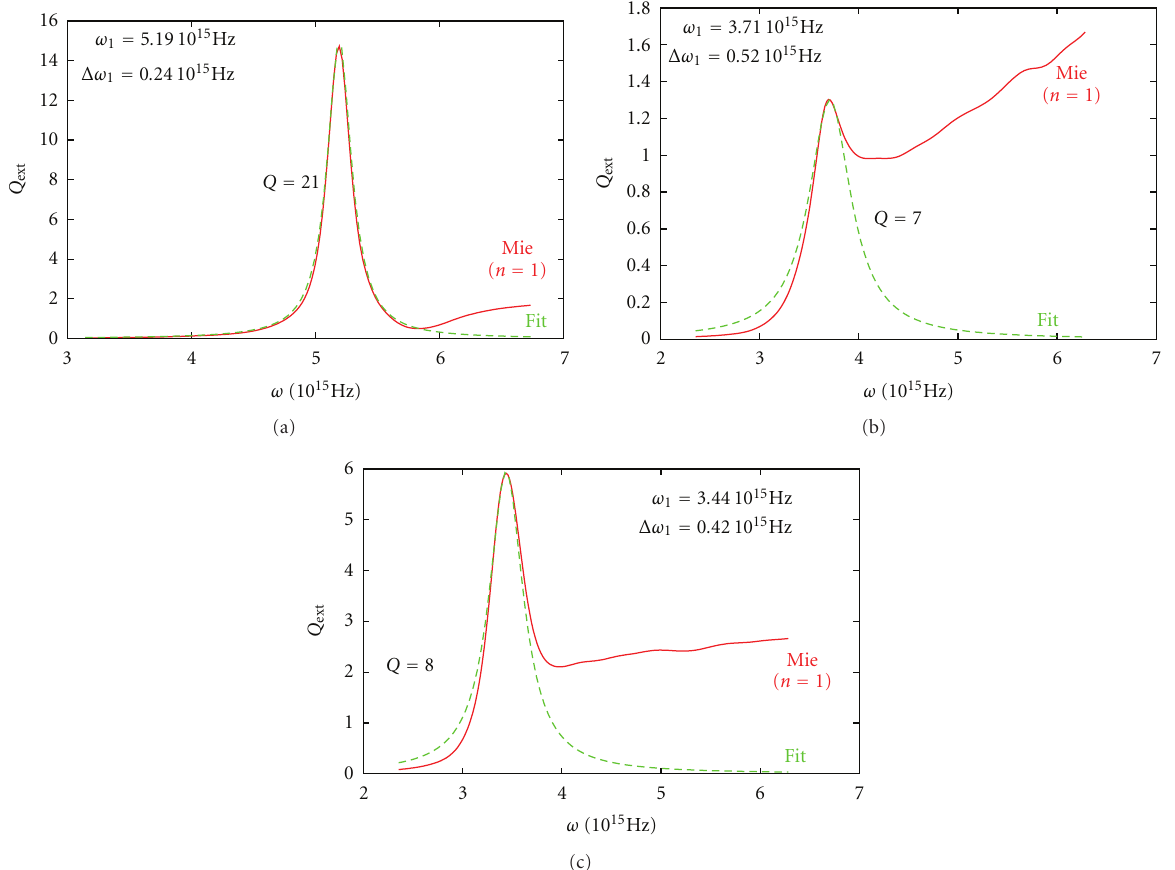
Figure 1: Extinction e ffi ciency for the dipolar resonance calculated keeping only the dipolar mode ( n = 1) in the Mie expansion and using experimental value for the metal dielectric constant [28]. (a) Silver particle in air. (b) Gold particle in air. (c) Gold particle in PMMA (optical index n B = 1 . 5). The particle radius is R = 25nm for each case. Fit refers to a Lorentzian fit using parameters indicated on the